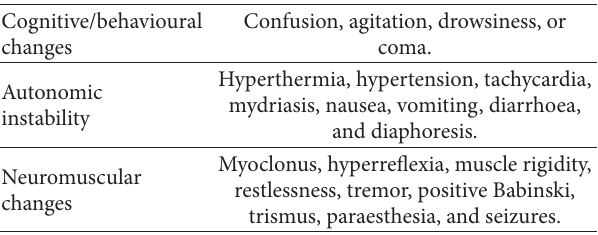
Table 1: Key clinical features of the serotonin syndrome [21].